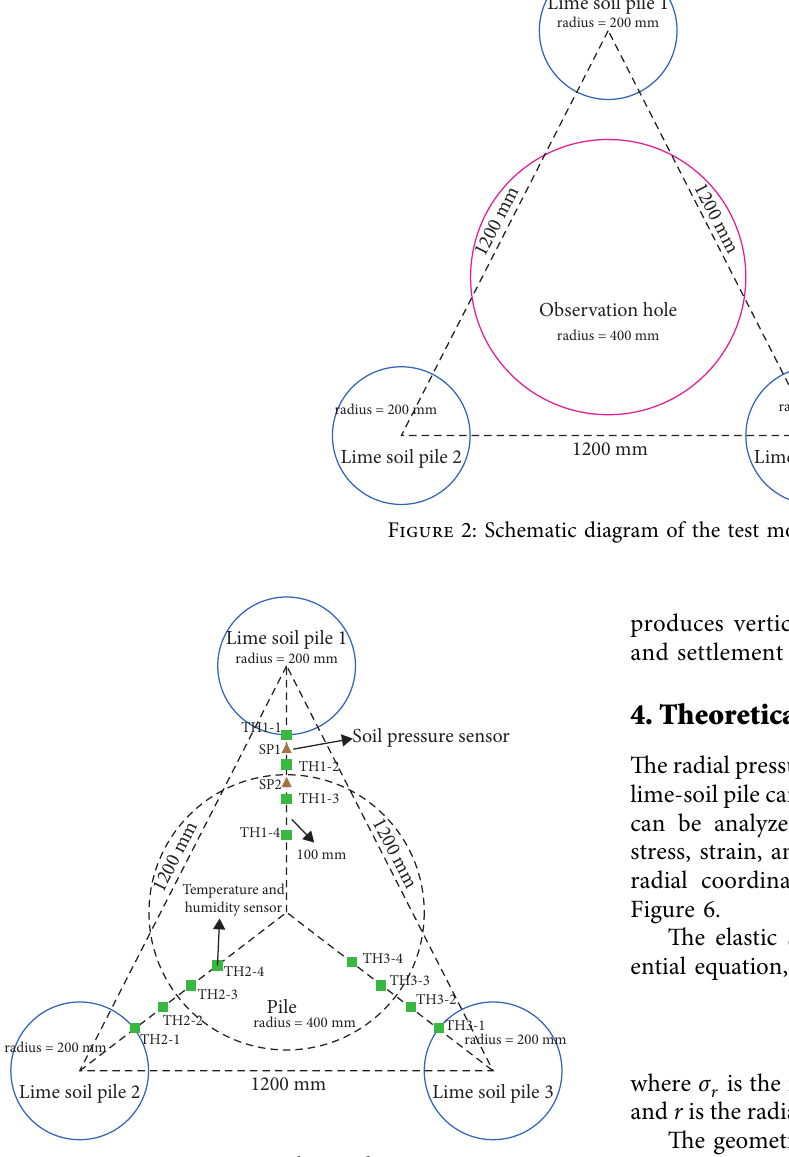
Figure 3: Sensor layout